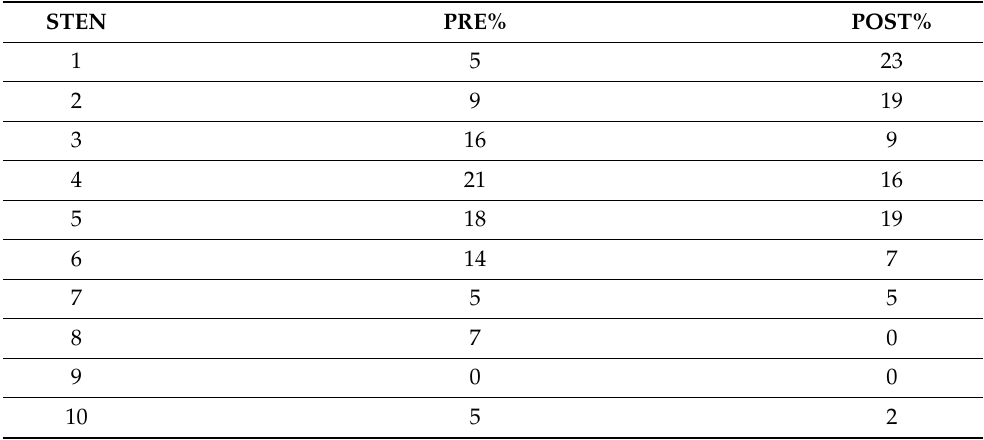
Table 6. Distribution of stress level scores in the study group in STEN (the higher the STEN, the higher the stress